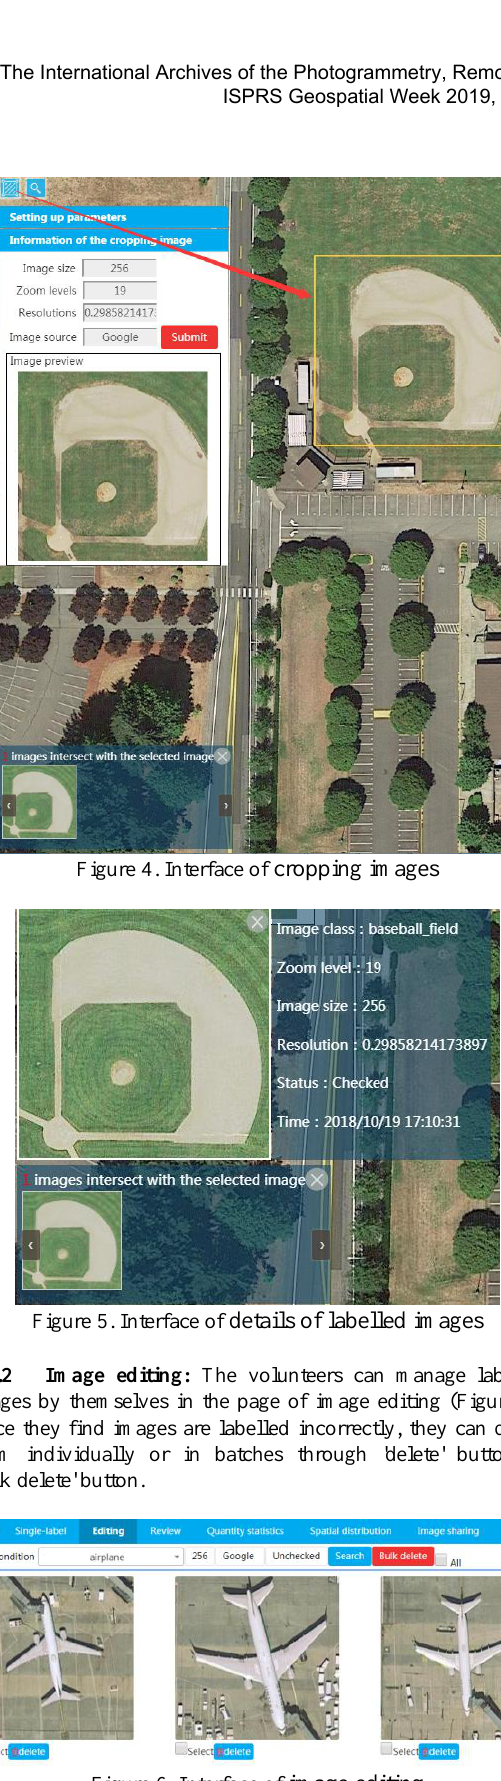
Figure 6. Interface of image editing